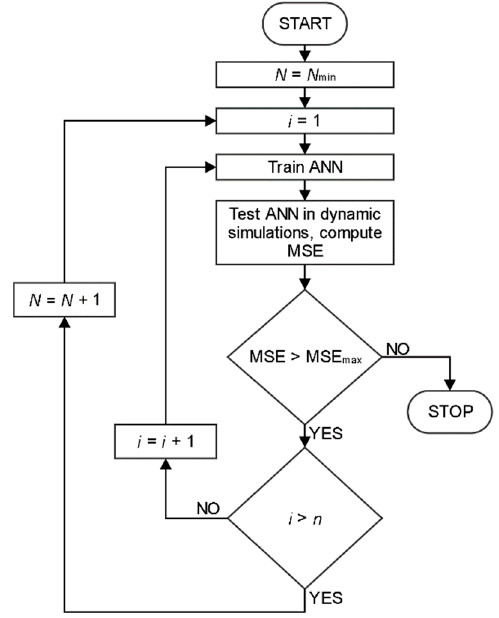
Figure 3. Algorithm for building, training, and testing artificial neural network (ANN) for hybrid simulation.